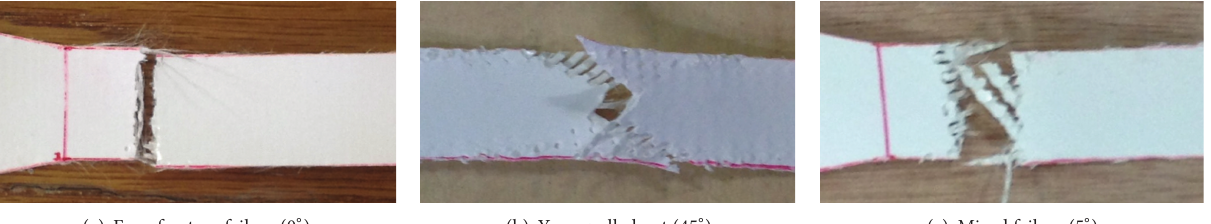
Figure 4: Failure modes of Precontraint 702 T2.